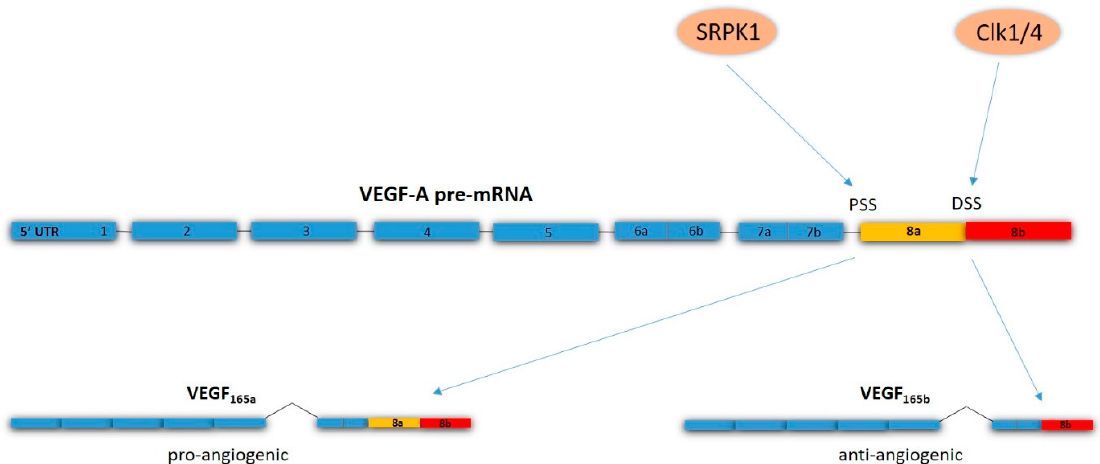
Figure 3. Alternative splicing of VEGF-A. Splicing at the proximal splicing site (PSS) is stimulated by serine-arginine protein kinase 1 (SRPK1), and results in the pro-angiogenic VEGF 165a splice variant. Clk1 / 4 stimulates splicing at the distal splicing site (DSS), which results in the anti-angiogenic VEGF 165b isoform.